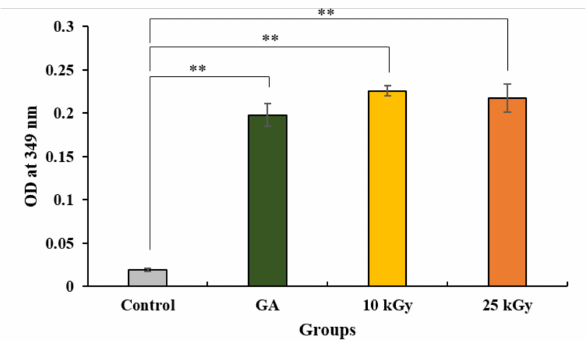
Figure 2. Quantification of amide groups of crosslinked collagen coated titanium implants. The symbol “*” indicates statistical significance compare to control (** p <